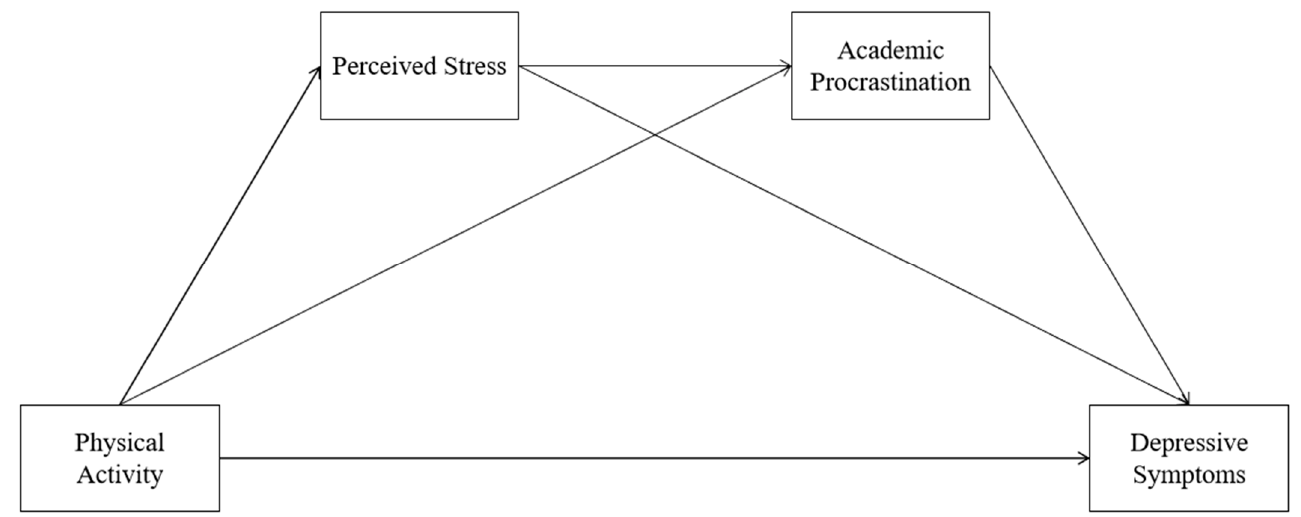
Figure 1. Hypothesized relationships between PA, perceived stress, academic procrastination and depressive symptoms.